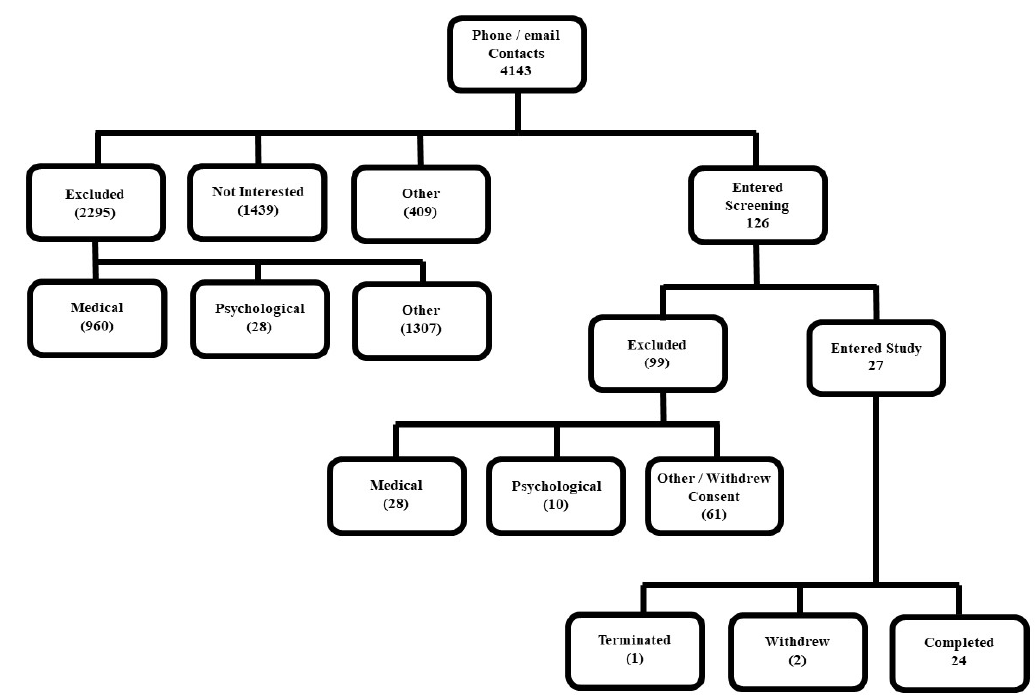
Figure 1. CONSORT flow diagram. The diagram shows participant exclusion and inclusion at di ff erent stages of the screening process for the representative study. The parenthetical values are the approximate number of participants excluded at various stages, whereas positive values (no parenthesis) represent inclusion at reflected